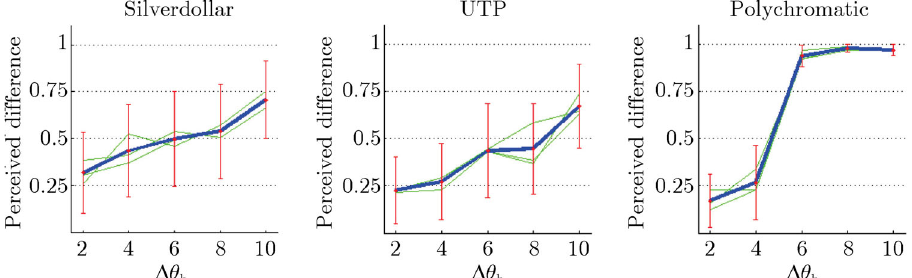
Fig. 16 Psychometric data averaged along θ d from the experiment showing perceived difference and data variance as a function of sampling step along θ h . The original functions for θ d = 2 ◦ , 8 ◦ , 14 ◦ are shown as green